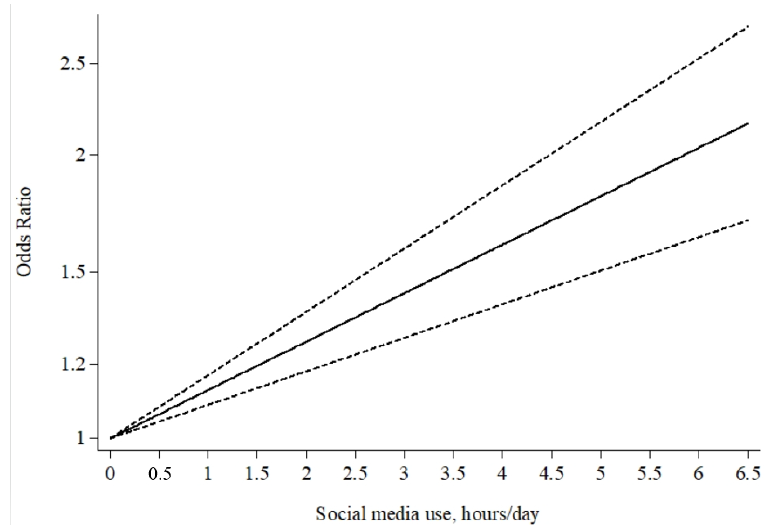
Figure 4. The generalized least squares trend estimated dose–response of time spent on social media and risk of depression in adolescents. Time of social media use was modelled with a restricted cubic spline in a two-stage random-effects dose–response model. The ORs are plotted on the log scale. Dashed lines represent the 95%CIs for the spline model. No social media use served as the referent